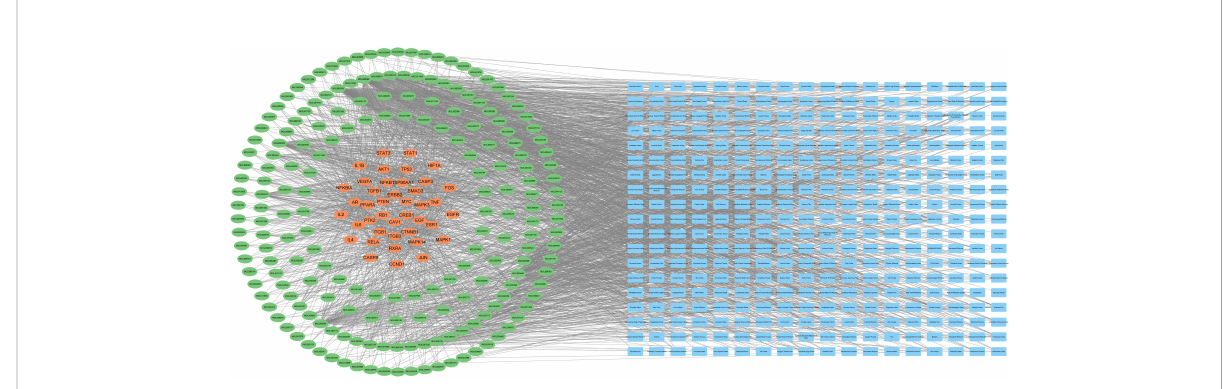
FIGURE 4 The 47 targets-913 chemical components-469 herbs network. Orange, green, and blue nodes represented the targets, chemical components, and herbs,